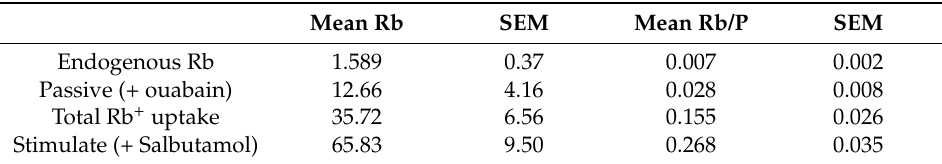
Figure 3. Rb + uptake by the Na,K-ATPase measured by ICP-MS in mouse EDL fibers. Samples of 2–5 fibers were incubated for 4 min in each of four solutions: Rb-free Tyrode’s (endogenous Rb + content); uptake solution containing 500 µ M RbCl, 5.5 mM K + and 1 mM ouabain (non-specific Rb + uptake); uptake solution without ouabain (total basal Rb + uptake in quiescent fibers); or uptake solution containing an agonist (10 µ M salbutamol) of Na,K-ATPase transport (stimulated Rb + uptake). Rb + concentrations were normalized to the P concentration of each sample, Rb/P. Each symbol represents a measurement from one sample. Each group included 12–13 samples (total: 24–65 fibers per group). All measurements were performed simultaneously in a multi-well platform. * and ** indicate significant difference of mean values at p < 0.05 and p < 0.01, respectively. Table 1. Components of Rb uptake in myofibers.